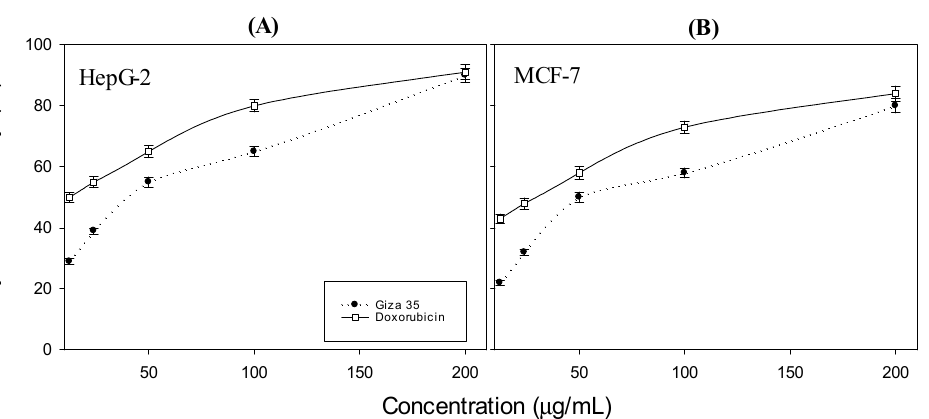
Figure 2. Cytotoxic activity of methanolic extracted from soybean Giza 35 at different concentrations (12.5, 25, 50, 100, and 200 µg/mL) against HepG-2 ( A ) and MCF-7 ( B ) compared to that of Doxorubicin as a control. All data are expressed as the mean ( n = 3) with ±SD.